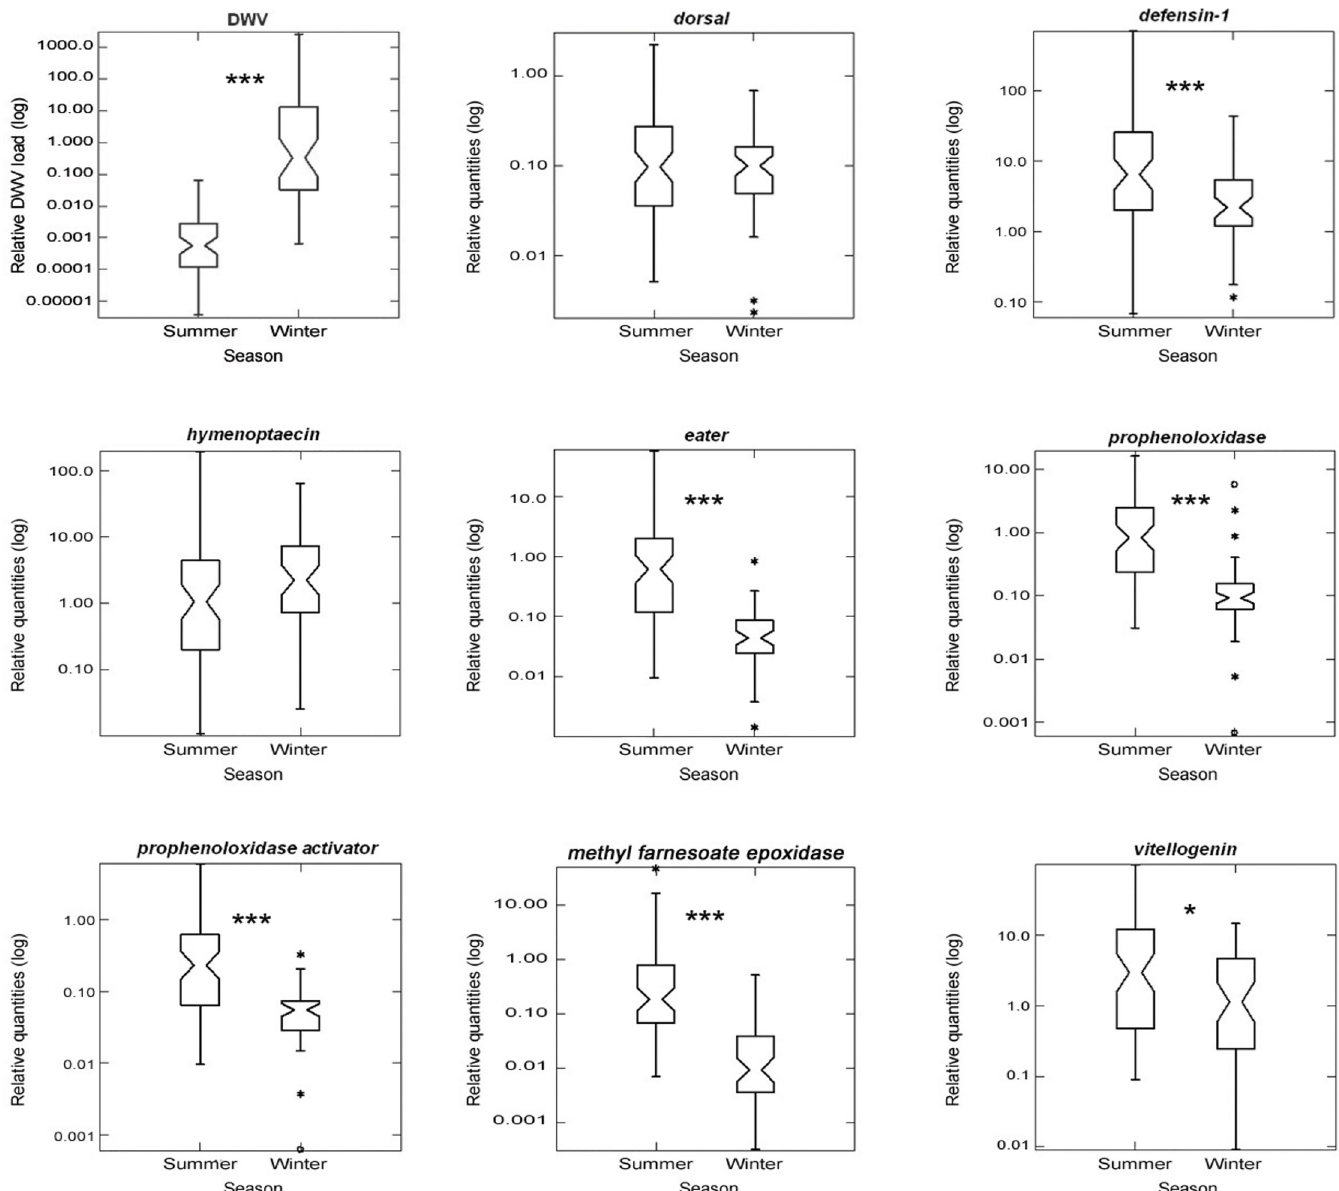
Fig 1. Variability of DWV load, expression of immune and physiological genes in summer (N = 67) and winter bees (N = 50) according to age. The Y- axis show the relative DWV genome copies per bee (log10) or the different genes expressions. The X-axis shows the age of the bees for both summer and winter samples. (Kruskal-Wallis Analysis of Variance, significant differences are indicated with * P < 0.05; *** P < 0.001). Gene expression profiles in summer and winter bees are indicated with continuous and dotted lines,